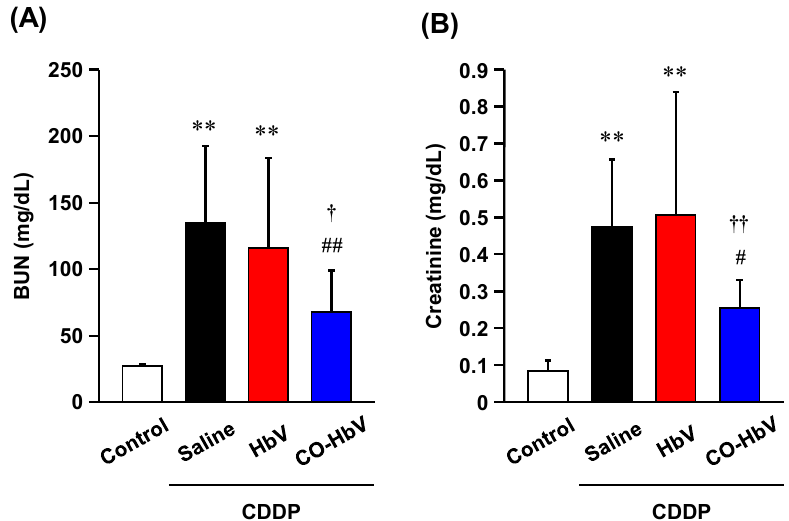
Figure 1. Biochemical analysis of kidney injury. The levels of ( A ) blood urea nitrogen (BUN) and ( B ) creatinine at 96 h after each sample treatment in cisplatin (CDDP) mice model. The data represent the mean ± standard deviation (S.D.). Control ( n = 8), saline ( n = 7), Hemoglobin-vesicle (HbV) ( n = 8), carbon monoxide (CO)-loaded HbV (CO-HbV) ( n = 8); ** p < 0.01 vs. control, # p < 0.05, ## p < 0.01 vs. Saline, † p < 0.05, †† p < 0.01 vs. HbV .